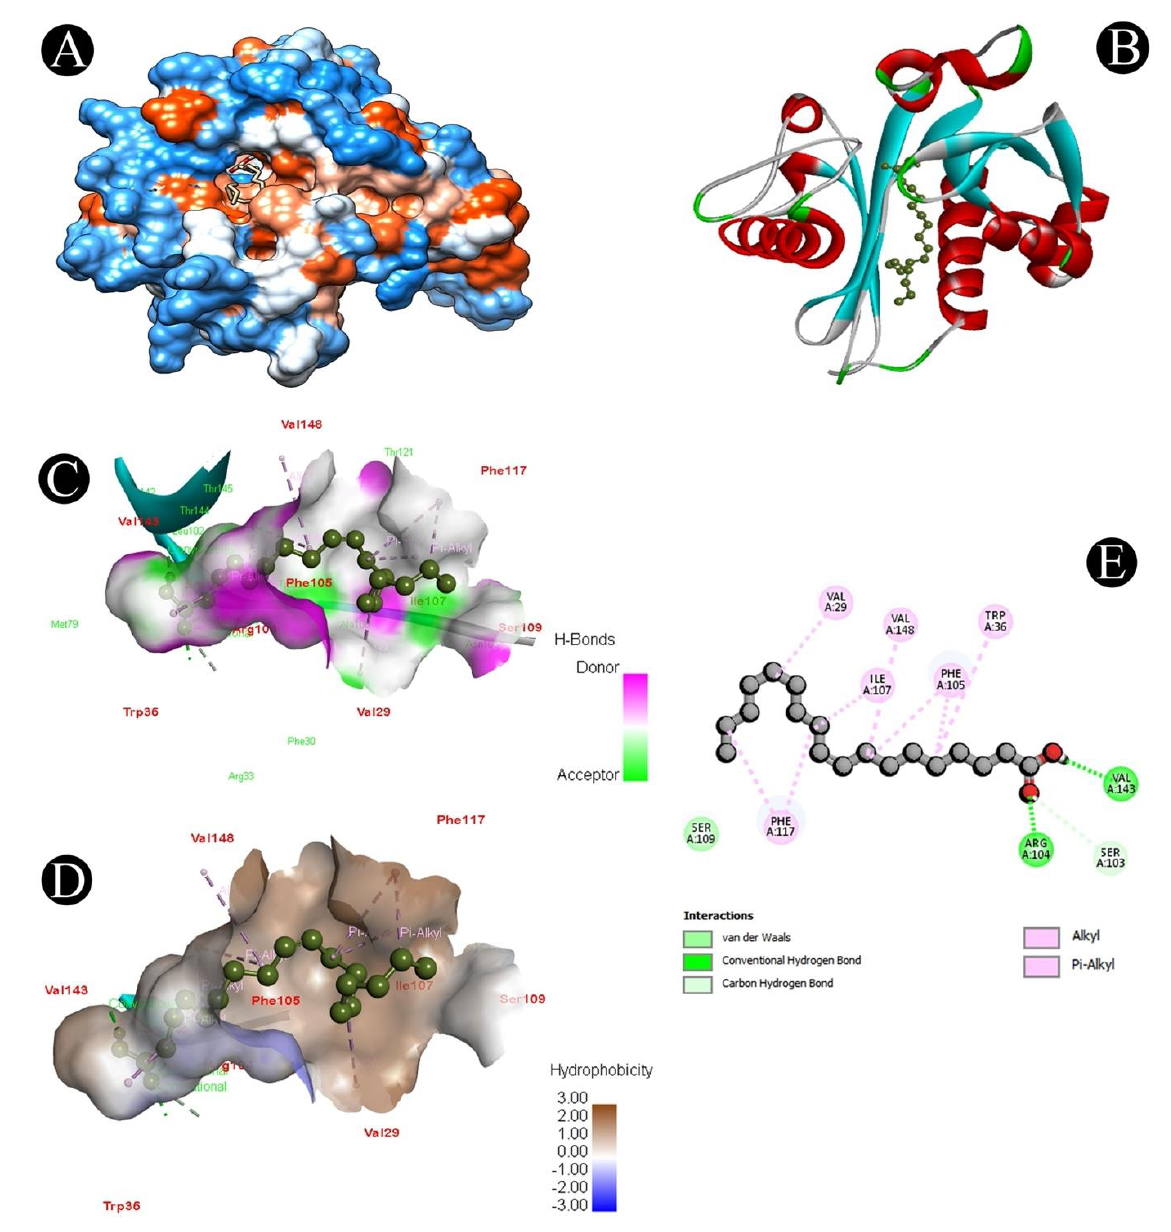
Figure 8. Visualization of the docking analysis of oleic acid binding with 1RO5. ( A ) Hydrophobicity surface 3D representation. ( B ) Interaction of oleic acid with 1RO5. ( C ) Visualization of hydrogen bond. ( D ) Visualization of hydrophobic interaction. ( E ) Two-dimensional representation describing the bindings of oleic acid with an active site of 1RO5.